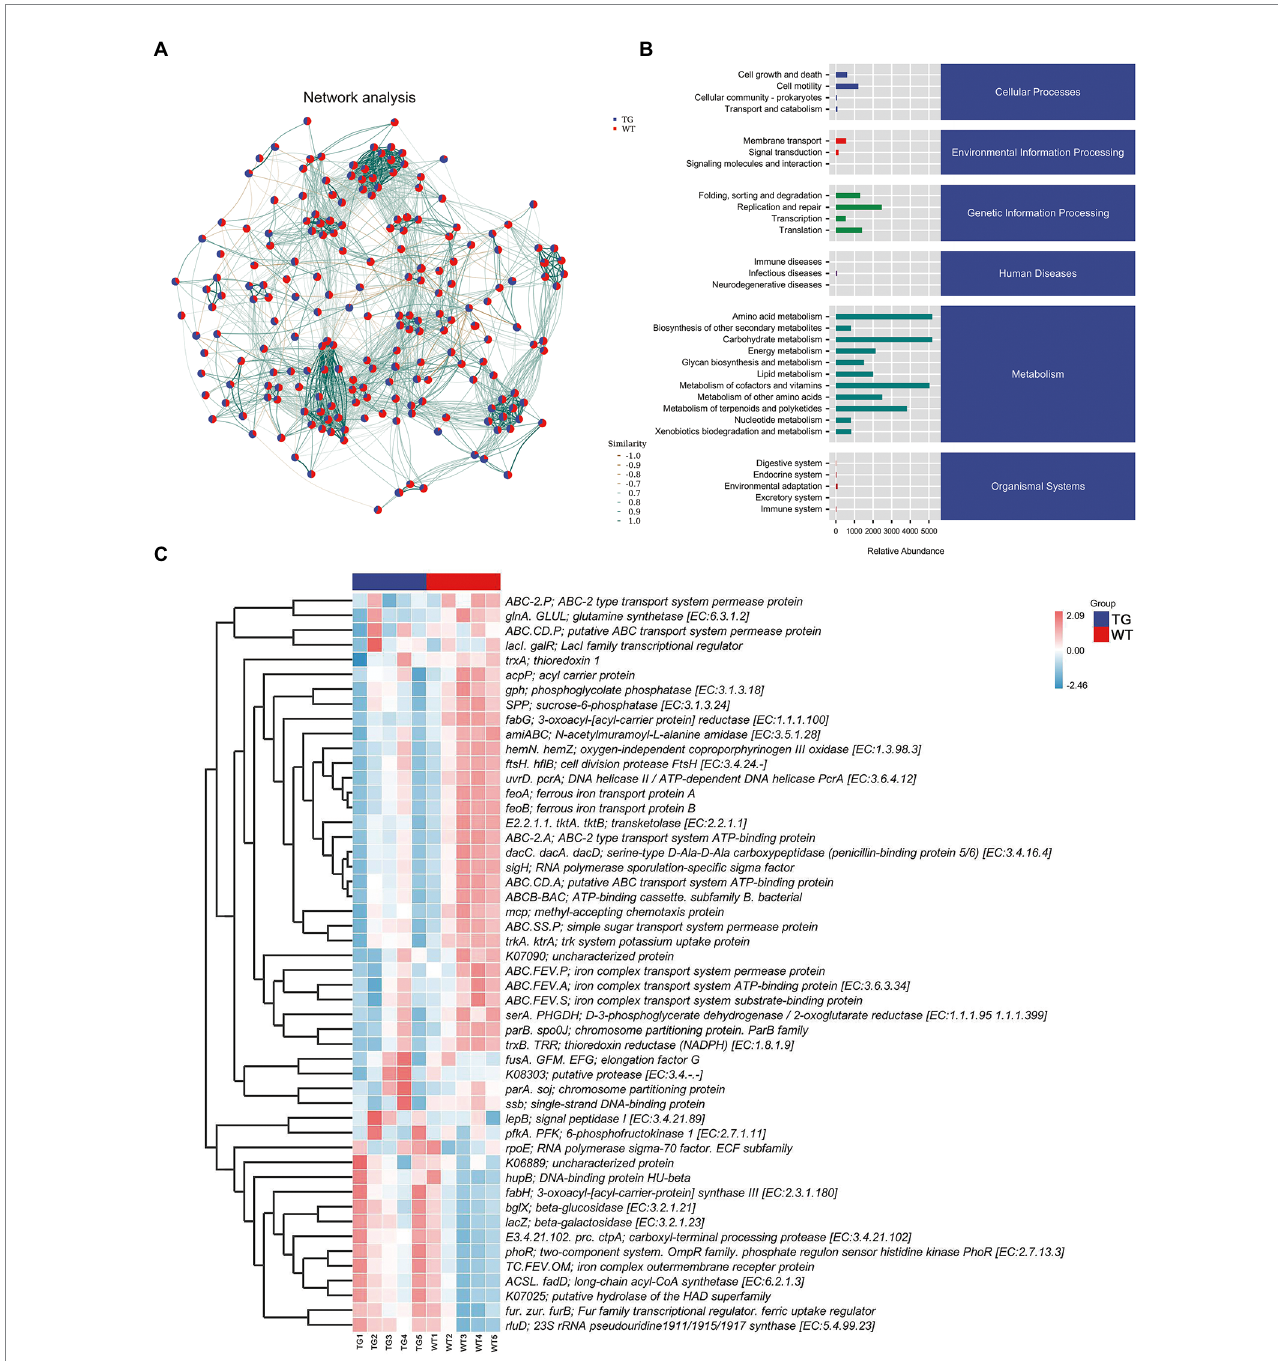
FIGURE. 7 Correlation analysis of intestinal microbiota and metabolic pathways. (A) Network analysis. The inter-node linkage indicates an association in the two nodes being joined. (B) The relative abundance of metabolic pathways. (C) The heat map of the KEGG enriched pathways. N = 5